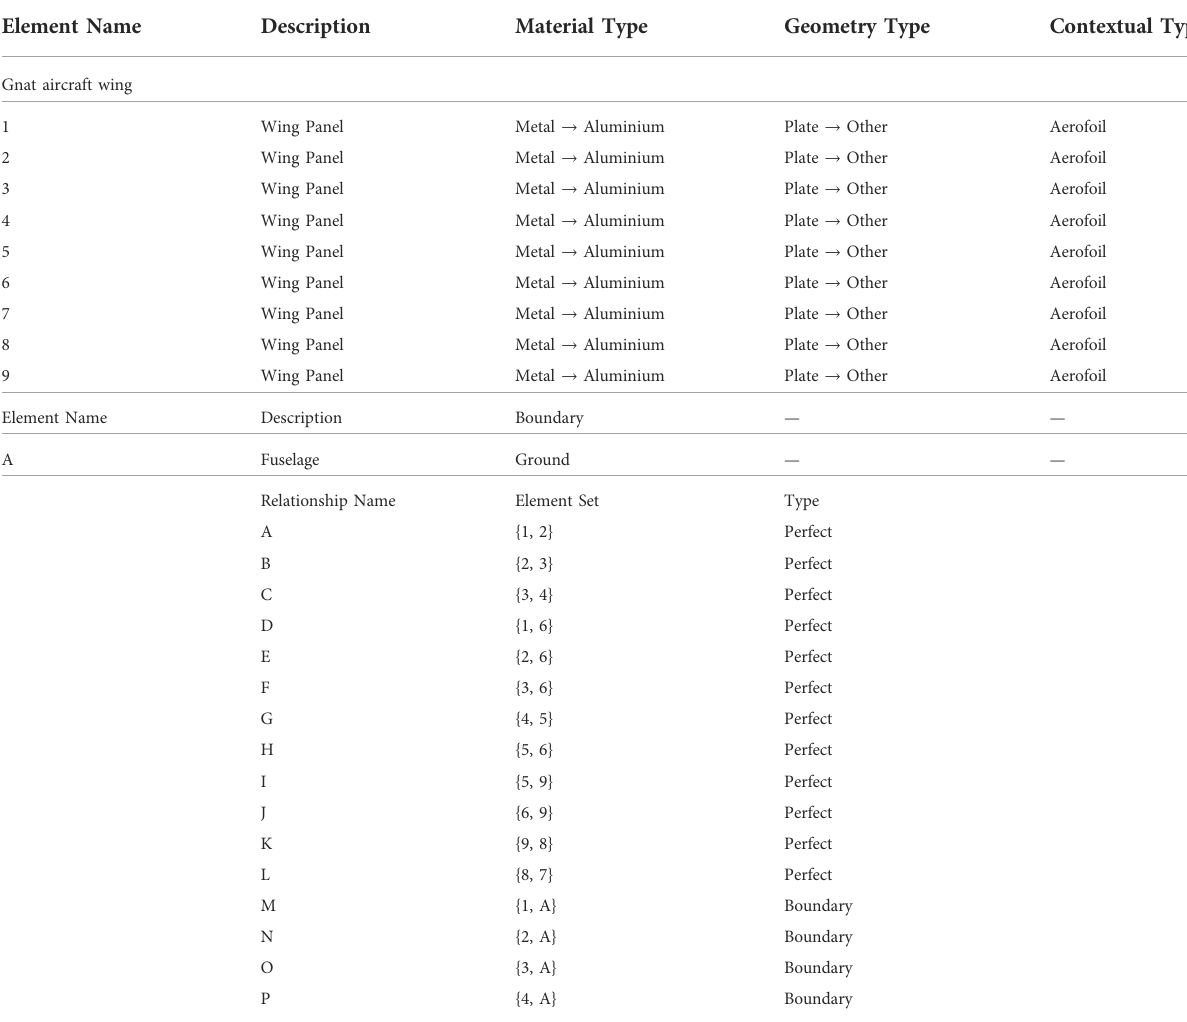
TABLE 8 List of elements and relationships, as well as their properties, for the Gnat aircraft